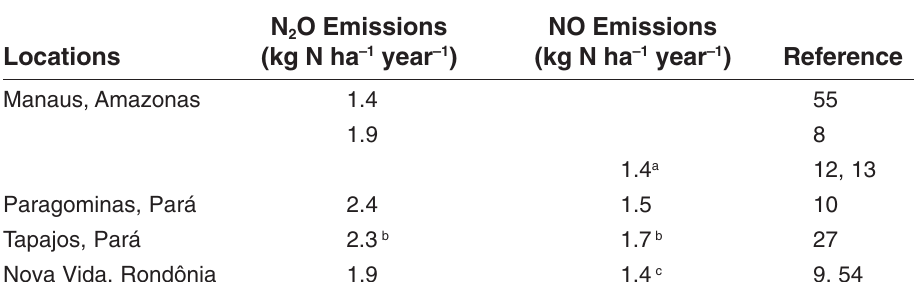
Emissions of N O and NO from Mature Forest Soils in the Brazilian 2